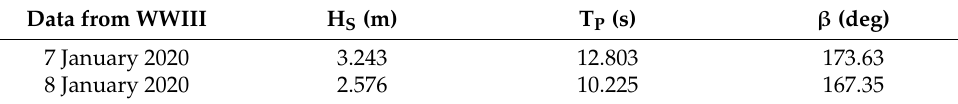
Figure 4. Weather forecast data—Wave period in seconds: ( a ) 7 January 2020 at 01.00 pm local time; ( b ) 8 January 2020 at 04.00 am local time. Table 3. Spectrum parameters.